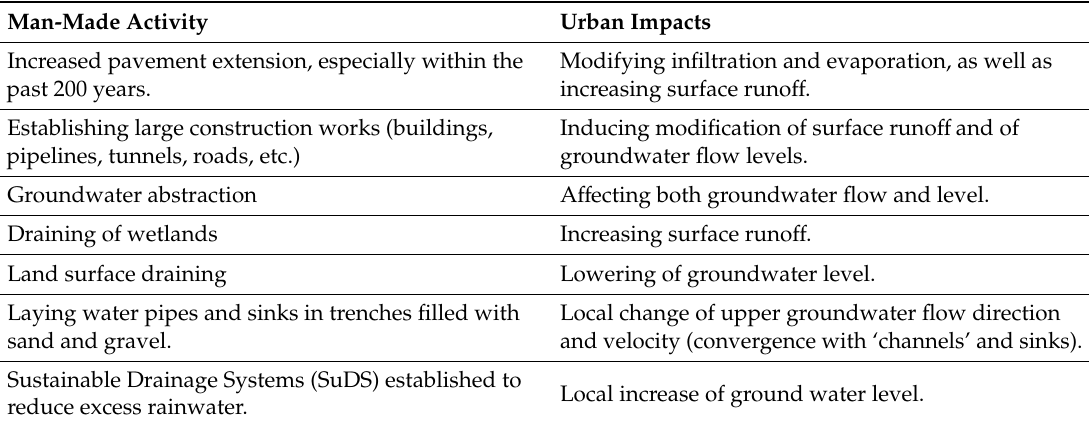
Table 4. Examples of man-made urban impacts a ff ecting the hydrological cycle within the last 200 years (Table based on authors experience from Odense and other